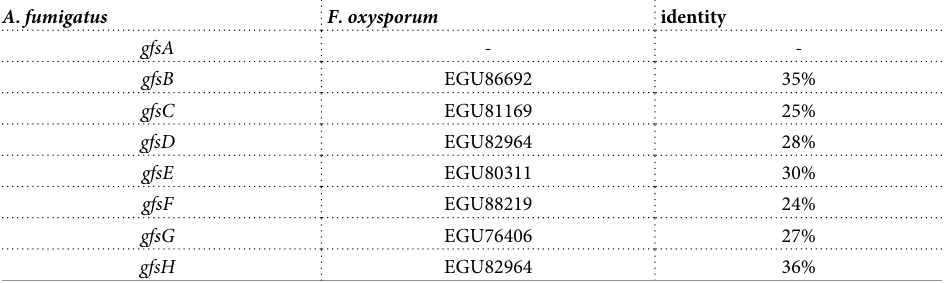
BLASTp searches of the A . fumigatus galactofuranosyltransferases A-H in the genome of F . oxysporum 5176 (https:// blast.ncbi.nlm.nih.gov). No GfsA homolog was found in the genome of EGU82964. EGU82964 encodes a homolog protein of GfsD (28% identity) and GfsH (36%